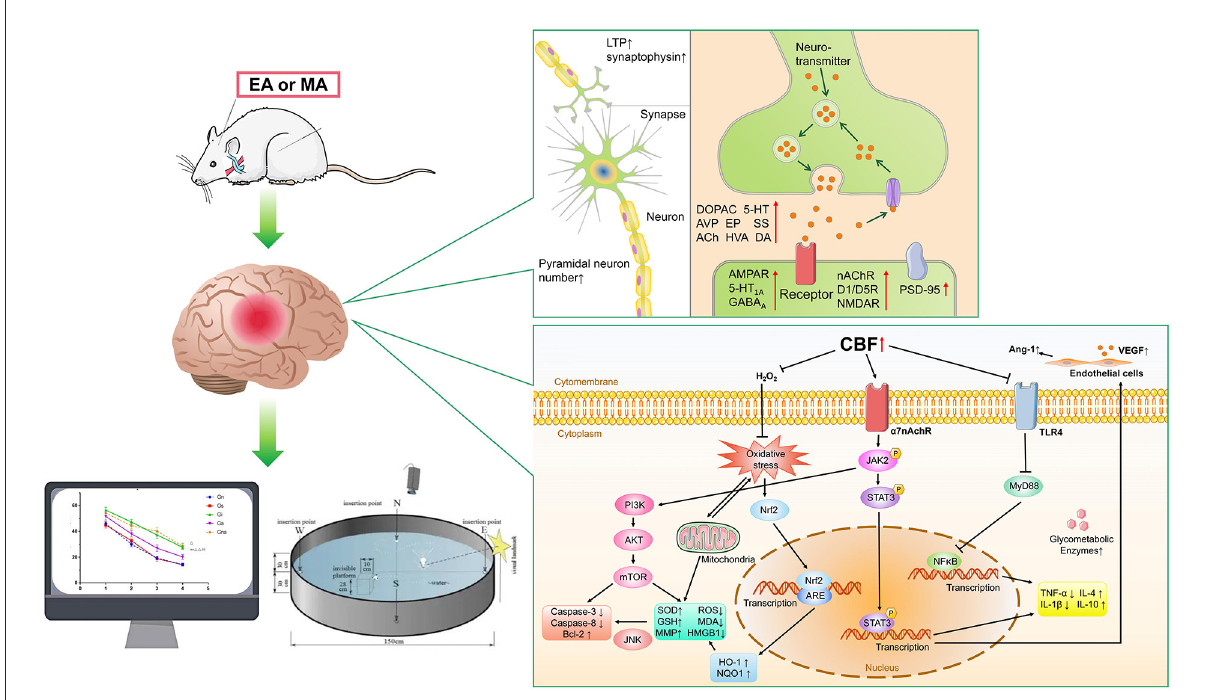
FIGURE4 The main mechanism of acupuncture in animal models of VD. EA, electroacupuncture; MA, manual acupuncture. Synapse function: LTP (Long-term Potential), AVP (arginine vasopressin), β -EP ( β -endorphine), SS (somatostatin), ACh (acetylcholine), HVA (homovanillic acid), DA (dopamine), DOPAC (Dihydroxyphenylaceticacid), 5-HT (5-hydroxytryptamine),EP (Epinephrine), nAChR (Nicotinic-Acetylcholine receptor), D1/D5R (dopamine 1/ dopamine5 receptor), NMDAR (N-methyl-D-aspartate receptor), AMPAR ( α -amino-3-hydroxy-5-methyl-4-isoxazole propionic acid receptor), GABA A R ( γ -amino-butyric acid type A receptor), 5-HT 1A R (postsynaptic serotonin (1A) receptors), PSD-95 (postsynaptic density-95). signal pathways: CBF (cerebral blood flow), Ang-1 (Angiopoietin-1), VEGF (vascular endothelial growth factor), TLR4 (Toll Like Receptor 4), MyD88 (myeloid differentiation factor 88), NF- κ B (nuclear factor-kappa B), α 7nAChR (alpha-7 nicotinic acetylcholine receptor), JAK2 (Janus Kinase 2), STAT3 (Signal Transducer and Activator of Transcription 3), TNF- α (Tumor Necrosis Factor- α ), IL-4 (interleukin 4), IL-10 (interleukin 10), IL-1 β (interleukin 1 β ), Nrf2 (Nuclear factor erythroid2-related factor2), ARE (antioxidant response element), HO-1 (heme oxygenase), NQO1 (NADP (H) quinone oxidoreductase), ROS (reactive oxygen species), MDA (Malon-dialdehyde), SOD (superoxide